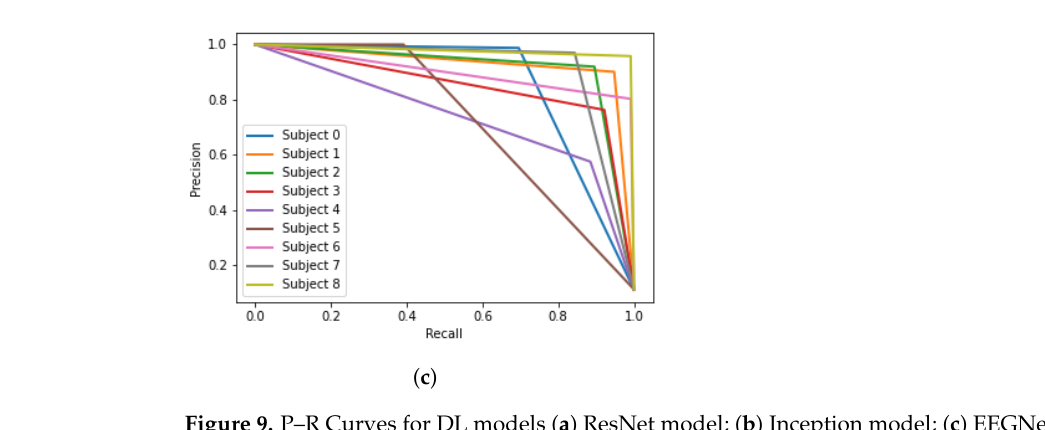
Figure 9. P–R Curves for DL models ( a ) ResNet model; ( b ) Inception model; ( c ) EEGNet model.